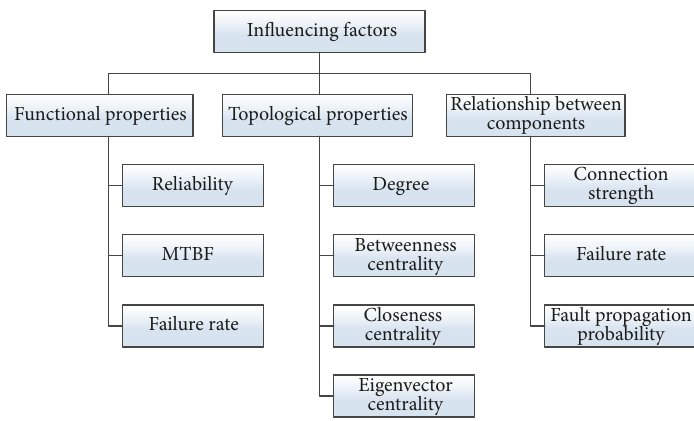
Figure 2: Influencing factors of the individual